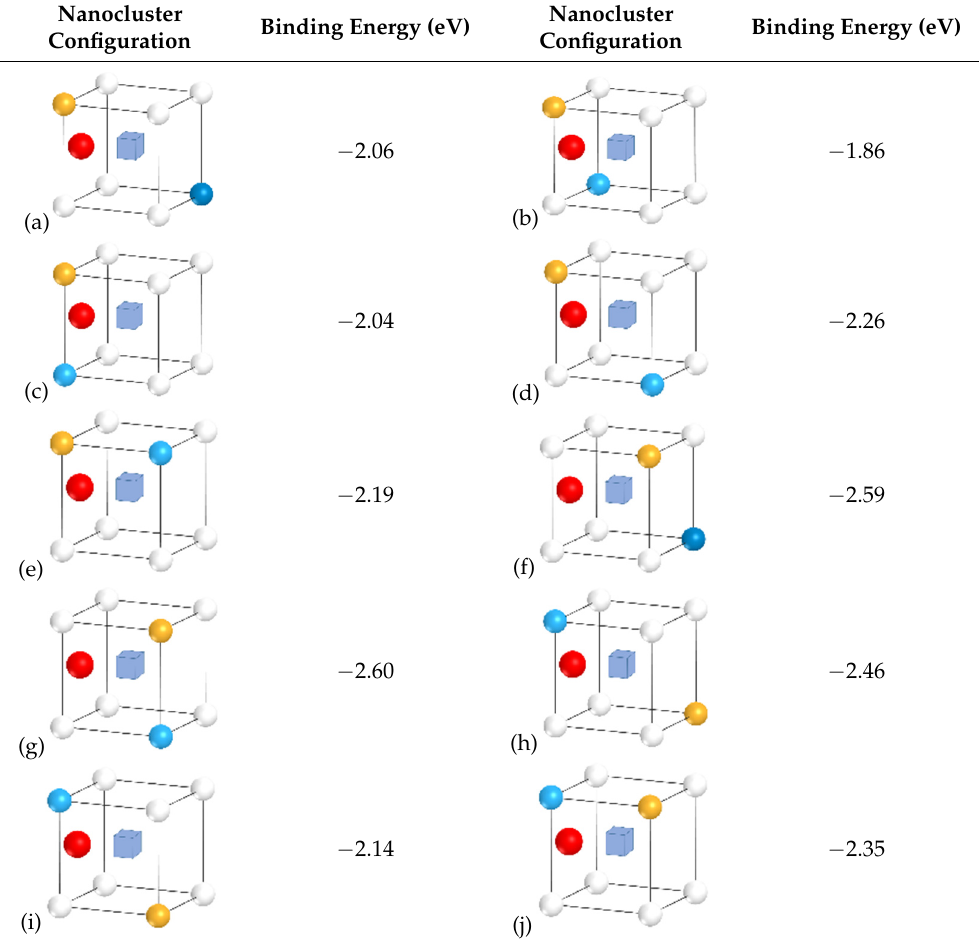
Table 6. Binding energies of 10 non-stoichiometric Y-Si-O nanoclusters ( a – j ) in bcc Fe (White atoms are Fe atoms, red is O, yellow is Si, blue is the Y and the purple cube is the vacancy ( v )). Nanocluster Configuration Binding Energy (eV)